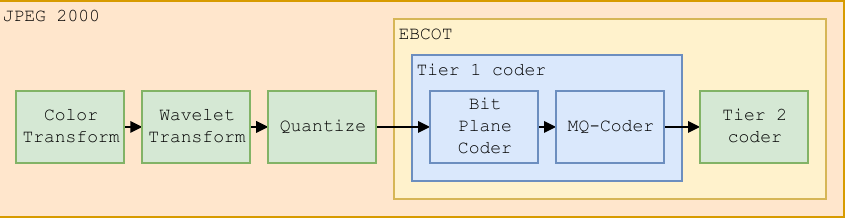
Figure 2. Diagram of the full JPEG2000 algorithm. In green, steps that deal with the whole image at once. In blue, steps that deal with small blocks of the